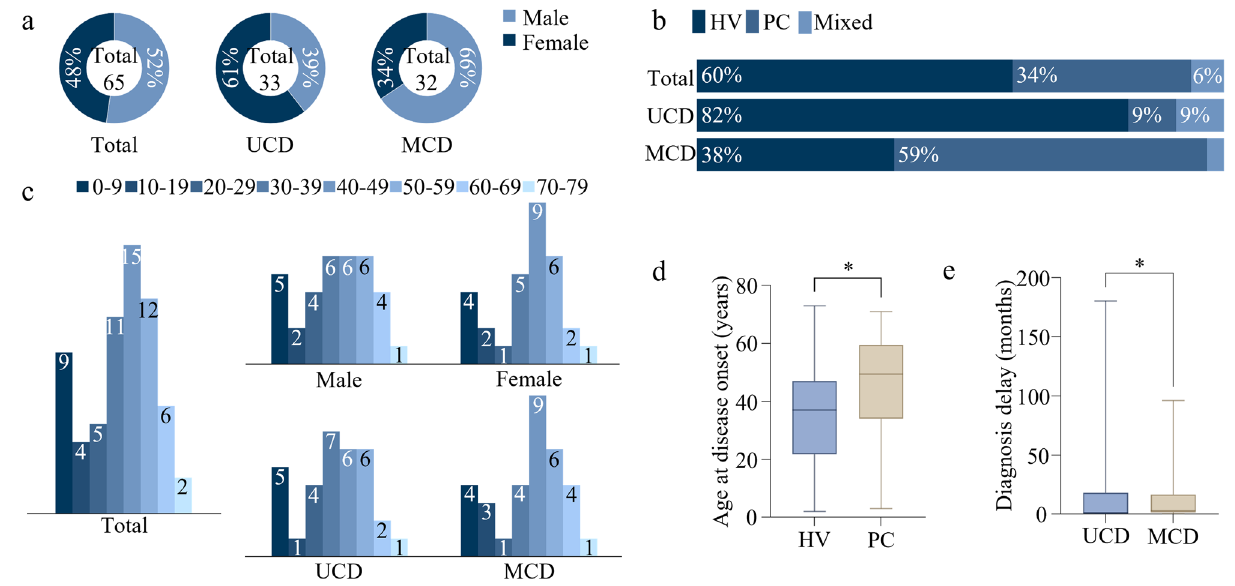
Figure 1. Epidemiologic characteristics. ( a ) Proportions of male and female in total, UCD and MCD patients; ( b ) Proportions of three microscopic subtypes of CD in total, UCD and MCD patients; ( c ) Distribution of CD patients in each age group; ( d ) The ages at disease onset (years) of HV and PC patients. *P = 0.0413 as determined by two-tailed Student’s t test. ( e ) The diagnosis delays (months) of UCD and MCD patients. *P = 0.0436 as determined by two-tailed Mann–Whitney U